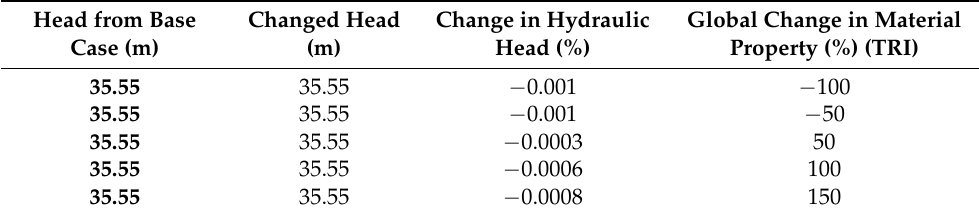
Figure 6. Observation location to observe the change in hydraulic head. Table 2. Variation of hydraulic head with changed material property (transfer rate in).